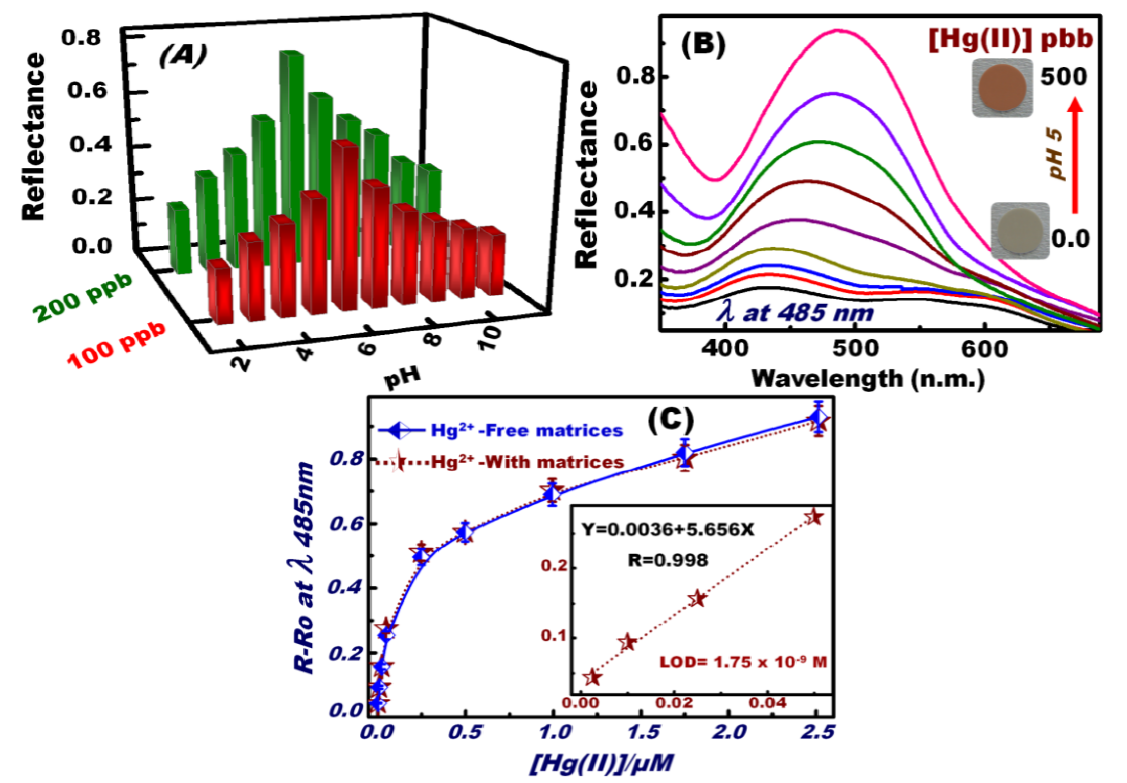
Figure 2. pH-dependent curves of OSM in the measurement of the reflectance spectra “signal” response and the color profiles of the [Hg–(DPTZ) 2 ] complex during the optical screening of Hg(II) ions at 485 nm ( A ); Reflectance spectra and sequential color response of OSM at different concentrations of Hg(II) ions at pH 5 ( B ). Calibration curve of the reflectance spectra of OSM for various Hg(II) concentrations at 485 nm. The inset in the graph shows the low-limit colorimetric responses of Hg(II) ions with a linear fit line in the linear concentration range before saturating the calibration curve ( C ). The solid line represents the calibration curve of the Hg(II) ions in the presence of active interfering species [ i.e ., Co(II), Mn(II), Cu(II), Zn(II), Fe(III), and Ni(II)] under the same sensing/screening